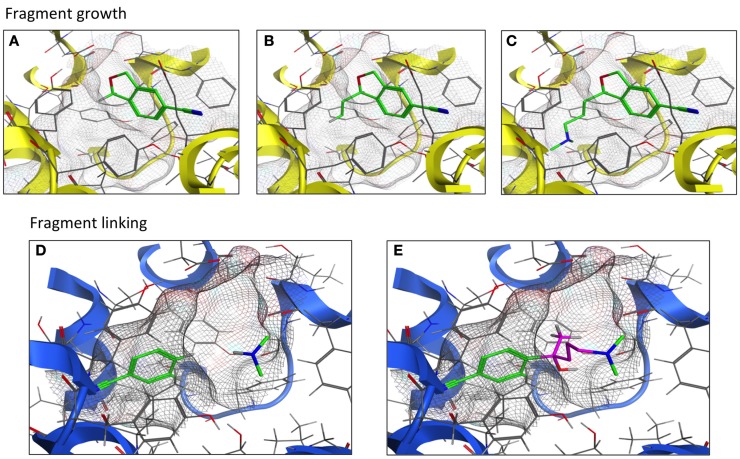
Fragment growth vs. fragment linking. Fragment growth (A–C) extends the fragment (green) to maximize interactions within the binding pocket (TM helices in yellow). Fragment linking (D,E) covalently joins (purple) two or more fragments (green) to form a novel-scaffold ligand within the binding pocket (TM helices in blue).